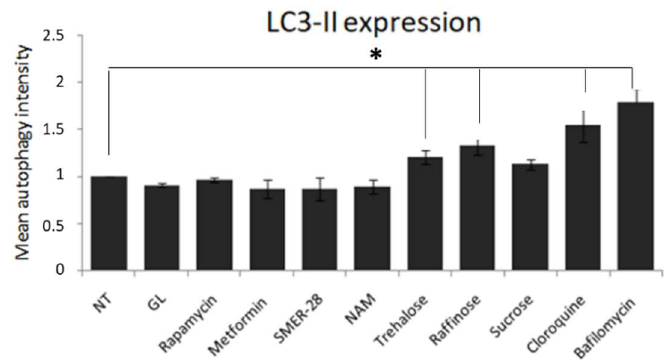
Figure 7. Cytofluorimetric analysis of LC3-II levels in Caco-2 confluent cells treated with different autophagy inducers. Rapamycin (5 µM), metformin (5 mM), SMER-28 (50 µM), NAM (5 mM), trehalose (100 mM), raffinose (100 mM), sucrose (100 mM), chloroquine (25 µM), and bafilomycin A1 (10 nM) were used to assess the autophagic flux. LC3-II expression values were normalized to NT sample. The analysis was performed using a Muse ® Cell Analyzer (Merck). The asterisks indicate p <